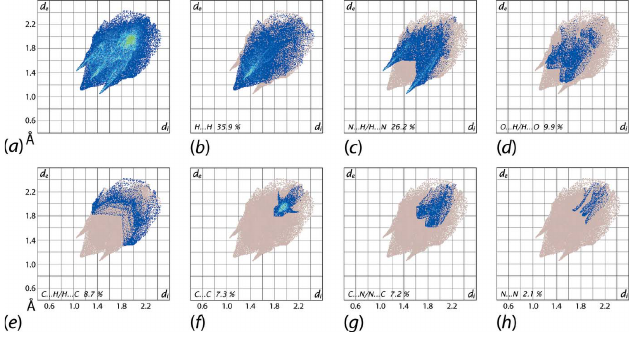
Figure 6 ( a ) The full two-dimensional fingerprint plot for (I) and ( b )-( h ) those delineated into H (cid:3)(cid:3)(cid:3) H, N (cid:3)(cid:3)(cid:3) H/H (cid:3)(cid:3)(cid:3) N, O (cid:3)(cid:3)(cid:3) H/H (cid:3)(cid:3)(cid:3) O, C (cid:3)(cid:3)(cid:3) H/H (cid:3)(cid:3)(cid:3) C, C (cid:3)(cid:3)(cid:3) C, C (cid:3)(cid:3)(cid:3) N/N (cid:3)(cid:3)(cid:3) C and N (cid:3)(cid:3)(cid:3) N contacts, respectively.